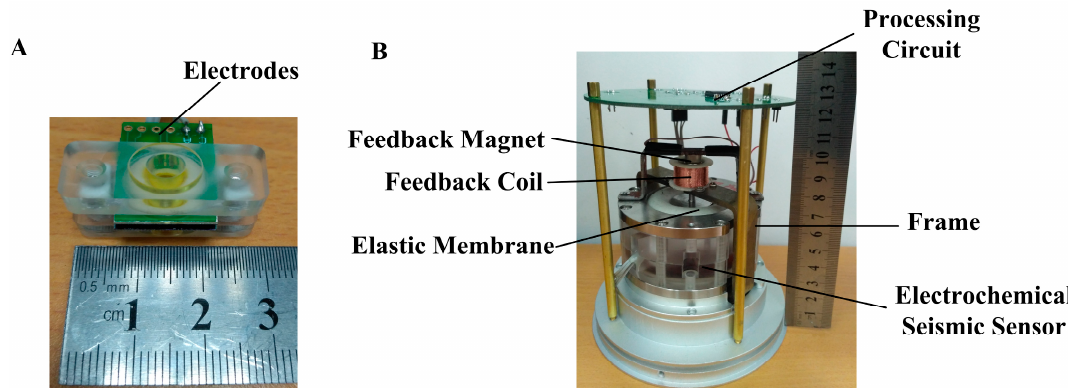
Figure 2. The sensing unit ( A ) and the prototype ( B ) of the MEMS electrochemical seismic sensors with force-balanced negative feedback. The inertial mass composed of the frame, the electrolyte, the membranes, and the feedback coil. The feedback coil and the feedback magnet were not connected together, which may have relative motion between the two components.